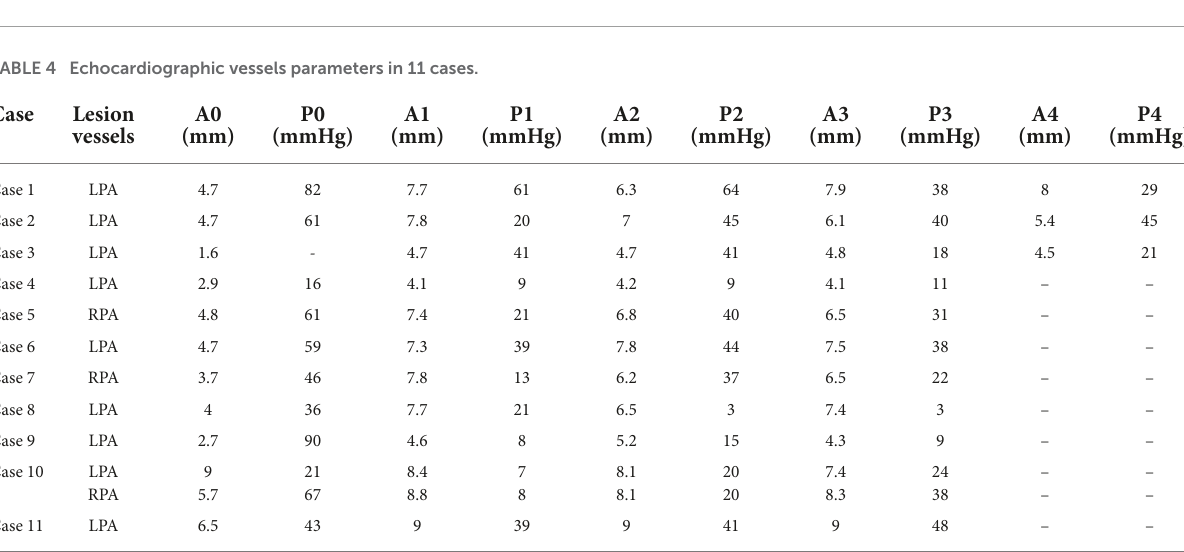
FIGURE5 The DSA images of before and after pulmonary artery stenting. (A) : case 1 had PA/VSD, LPS and implanted IBS; (B) : case 8 had TOF, LPS and implanted IBS; (C) : case 3 had VSD, LPS and implanted IBS; (D) : case 5 had TGA, RPS and implanted IBS.